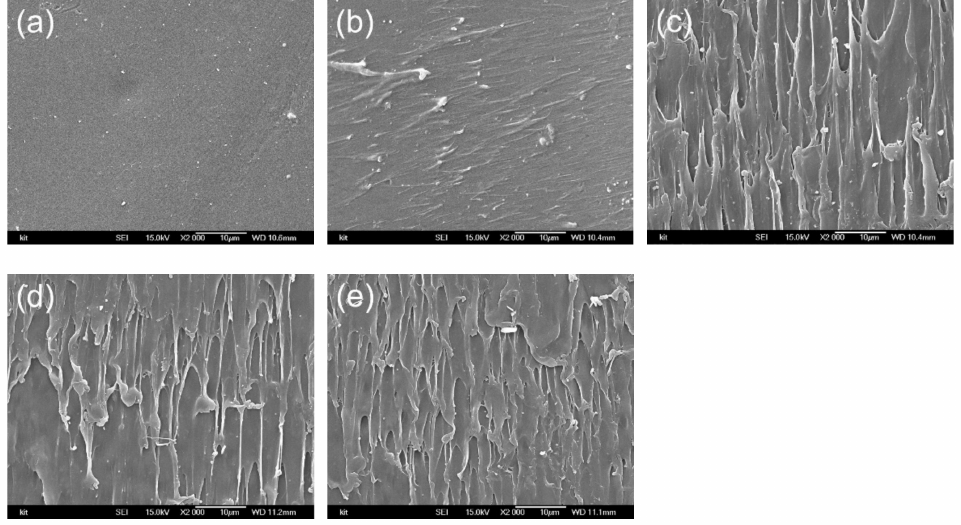
Figure 10. SEM images of polycarbonate (PC) aggregate: ( a ) 0 kGy; ( b ) 25 kGy; ( c ) 50 kGy; ( d ) 75